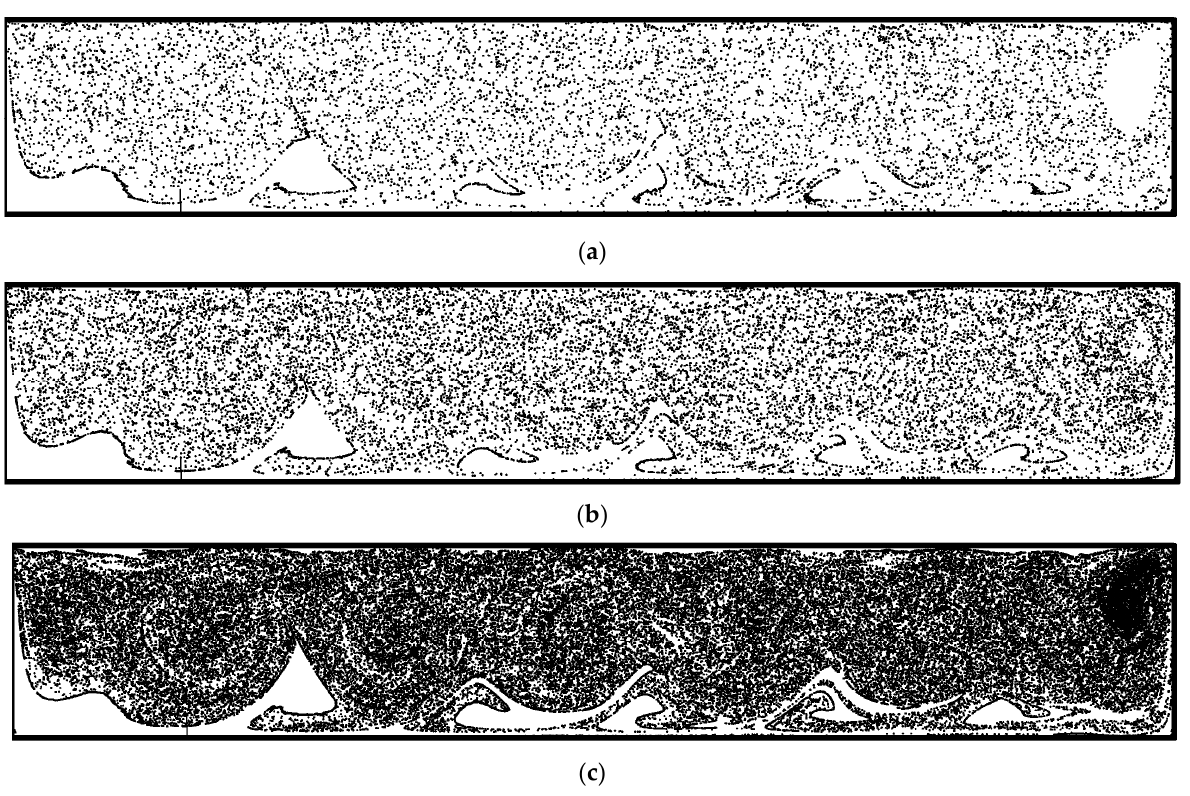
Figure 4. Distribution of particles (snapshot) for χ = 0.7 and different values of the Stokes number: ( a ) St = 10 − 5 , ( b ) St = 5 × 10 − 6 , and ( c ) St = 10 − 6 (the vertical extension is not to scale).